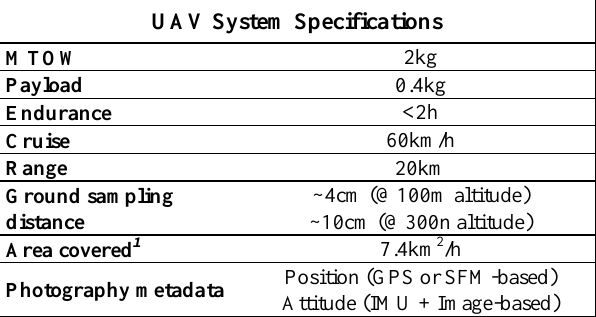
Table 1: Spin.Works S-20 key performance